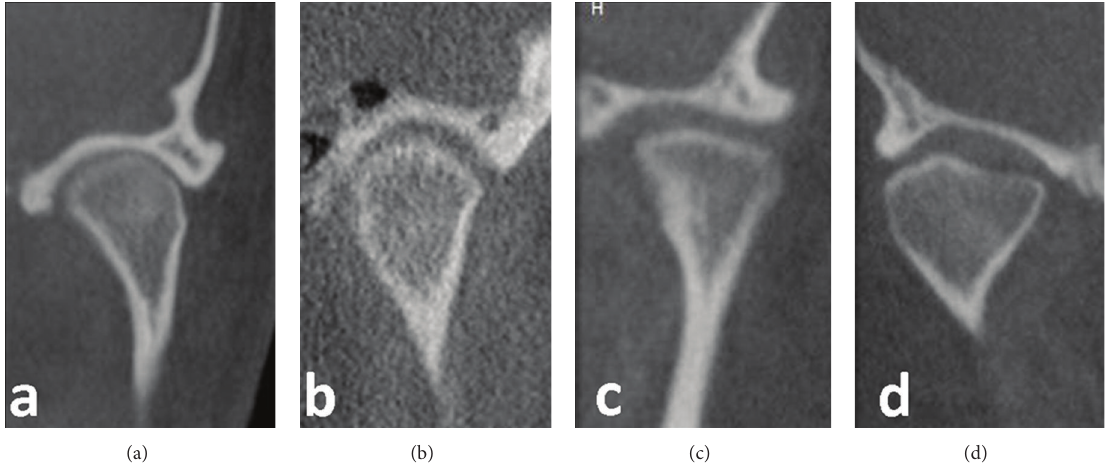
Figure 2: The coronal condyle morphology: (a) convex, (b) round, (c) flat, and (d) angled and other.